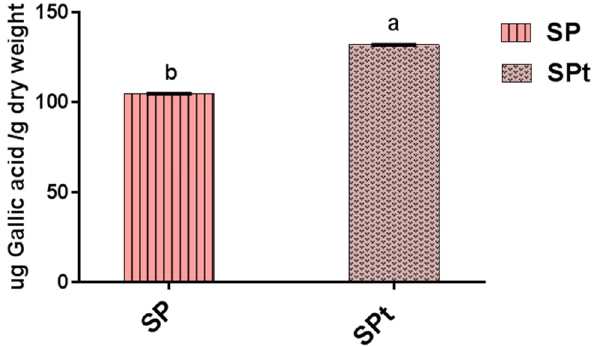
Figure 3: Antioxidant activity in methanolic extracts of SP and SPt for 21 days of culture based on DPPH free radical - scavenging activity ( % ) . Di ff erent letters mean signi fi cant change between groups ( p < 0.05 )